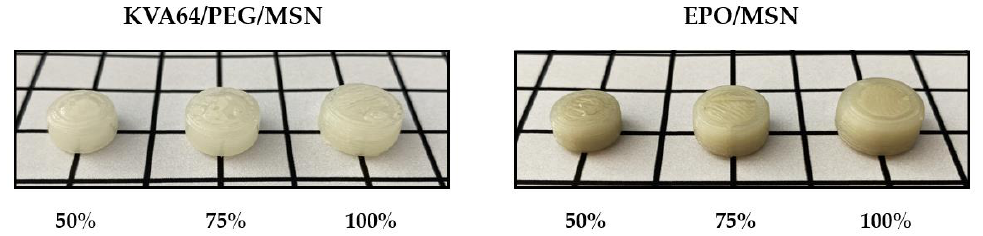
Figure 8. Sample 3DP tablets obtained from formulations KVA64/PEG/MSN and EPO/MSN. The volume scaling factors 100%, 75%, and 50% refer to the standard printlet file mentioned.